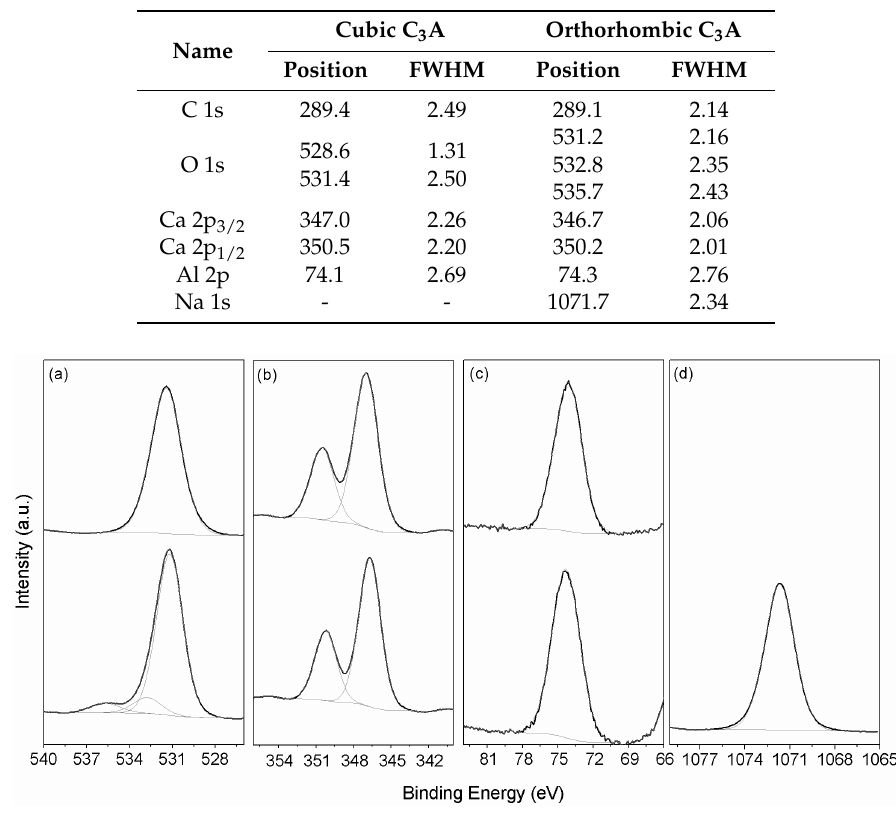
Figure 2. XPS spectra of the C 3 A cubic ( top ) and orthorhombic ( bottom ): ( a ) O 1s; ( b ) Ca 2p; ( c ) Al 2p; and ( d ) Na 1s.